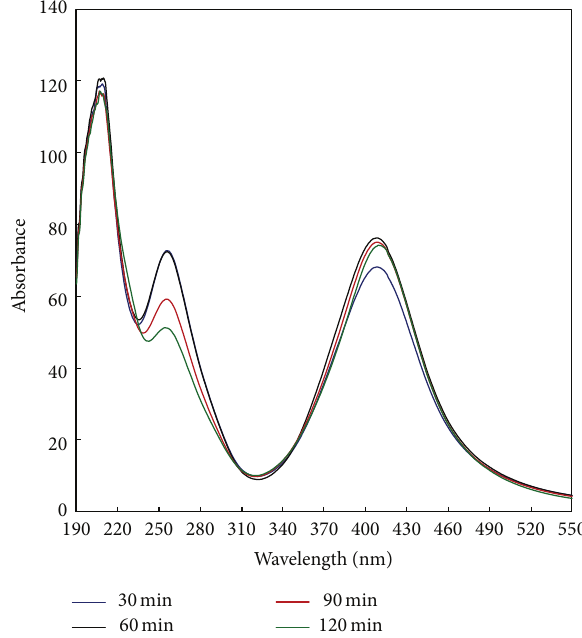
Figure 4: Effect of irradiation time on the synthesis of silver nanoparticles [CMS], 10 g/L; [PI], 1 g/L; [AgNO 3 ], 1g/L; temp., 30 ∘ C; time, 30–120 min.; M: L ratio, 1: 20; pH, 7.